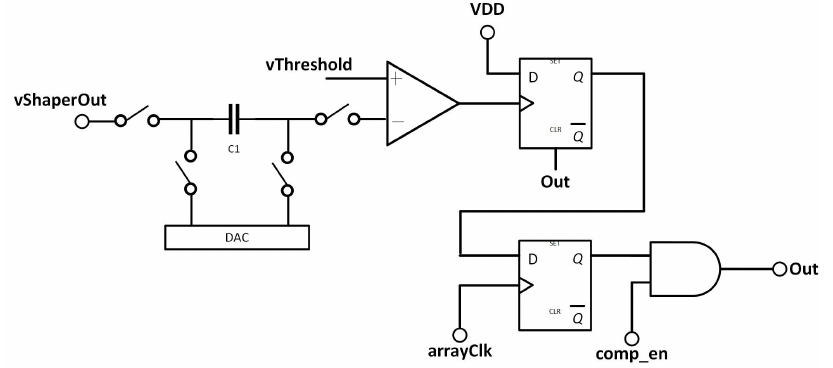
Figure 6. Diagram of the post-front end section of the pixel, showing the placement of the bias DAC, hit register and mask